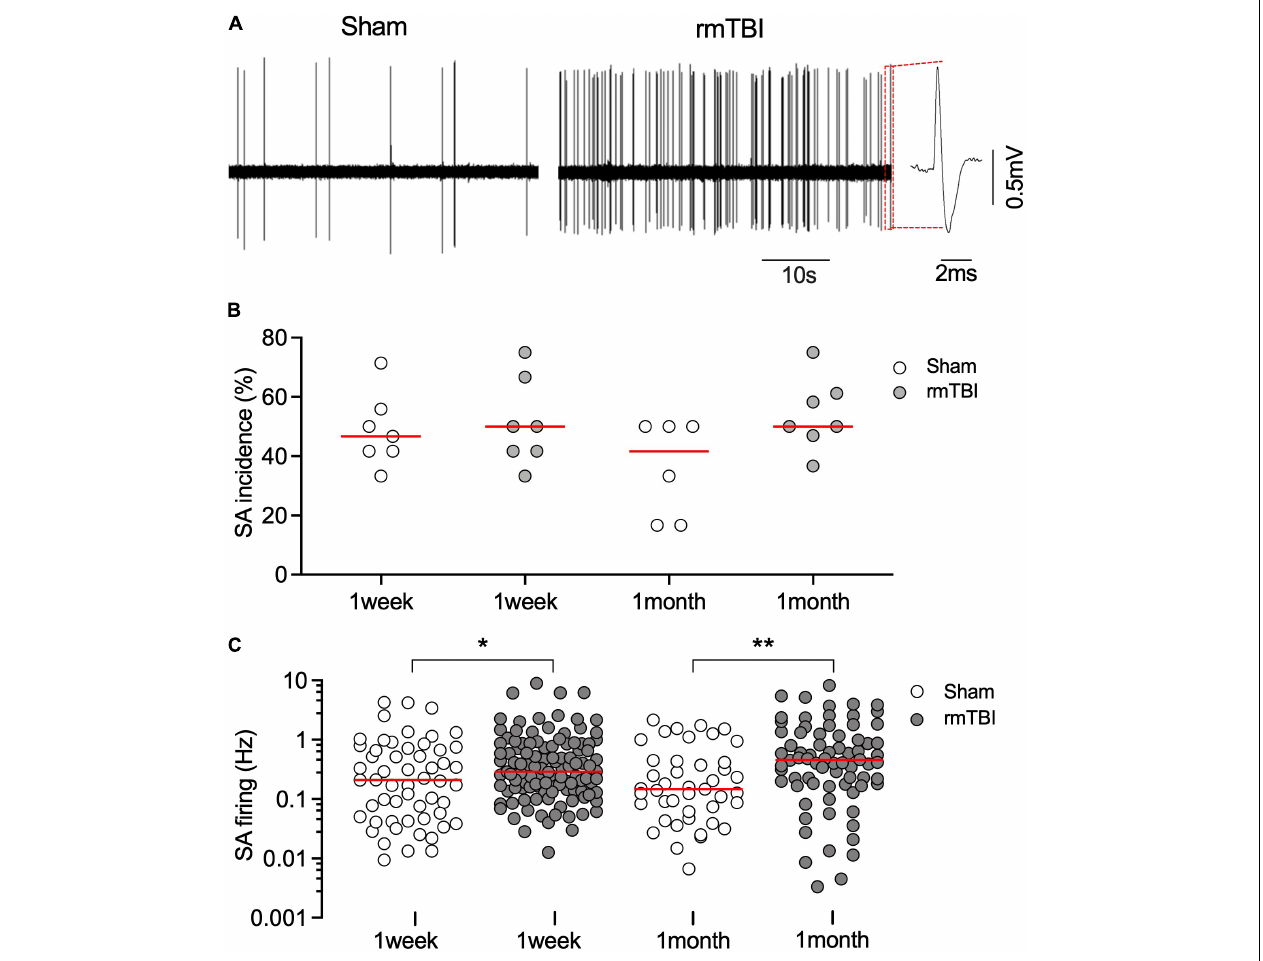
FIGURE 8 | rmTBI on excitatory neuronal activity in mPFC. (A) Sample recordings from rat 1 months after sham injury (left) and rmTBI (right) . (B) There is no difference in incidence of spontaneous firing between sham injury and rmTBI groups. Each dot represents recording from one rat. (C) Firing rates of spontaneous firing of mPFC pyramidal neurons are increased after rmTBI. Each dot represents data from one neuron recorded ( n = 6–7 rats per group showing in B ). Red bars represent means. * P < 0.05, ** P < 0.01 by the planned comparison with Bonferroni